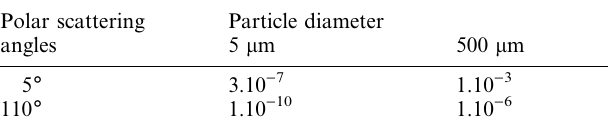
Table 2. Values of the scattered energy (W cm ) 2 ) at 5 (cid:176) and 110 (cid:176) for two particle diameters Polar scattering Particle diameter angles